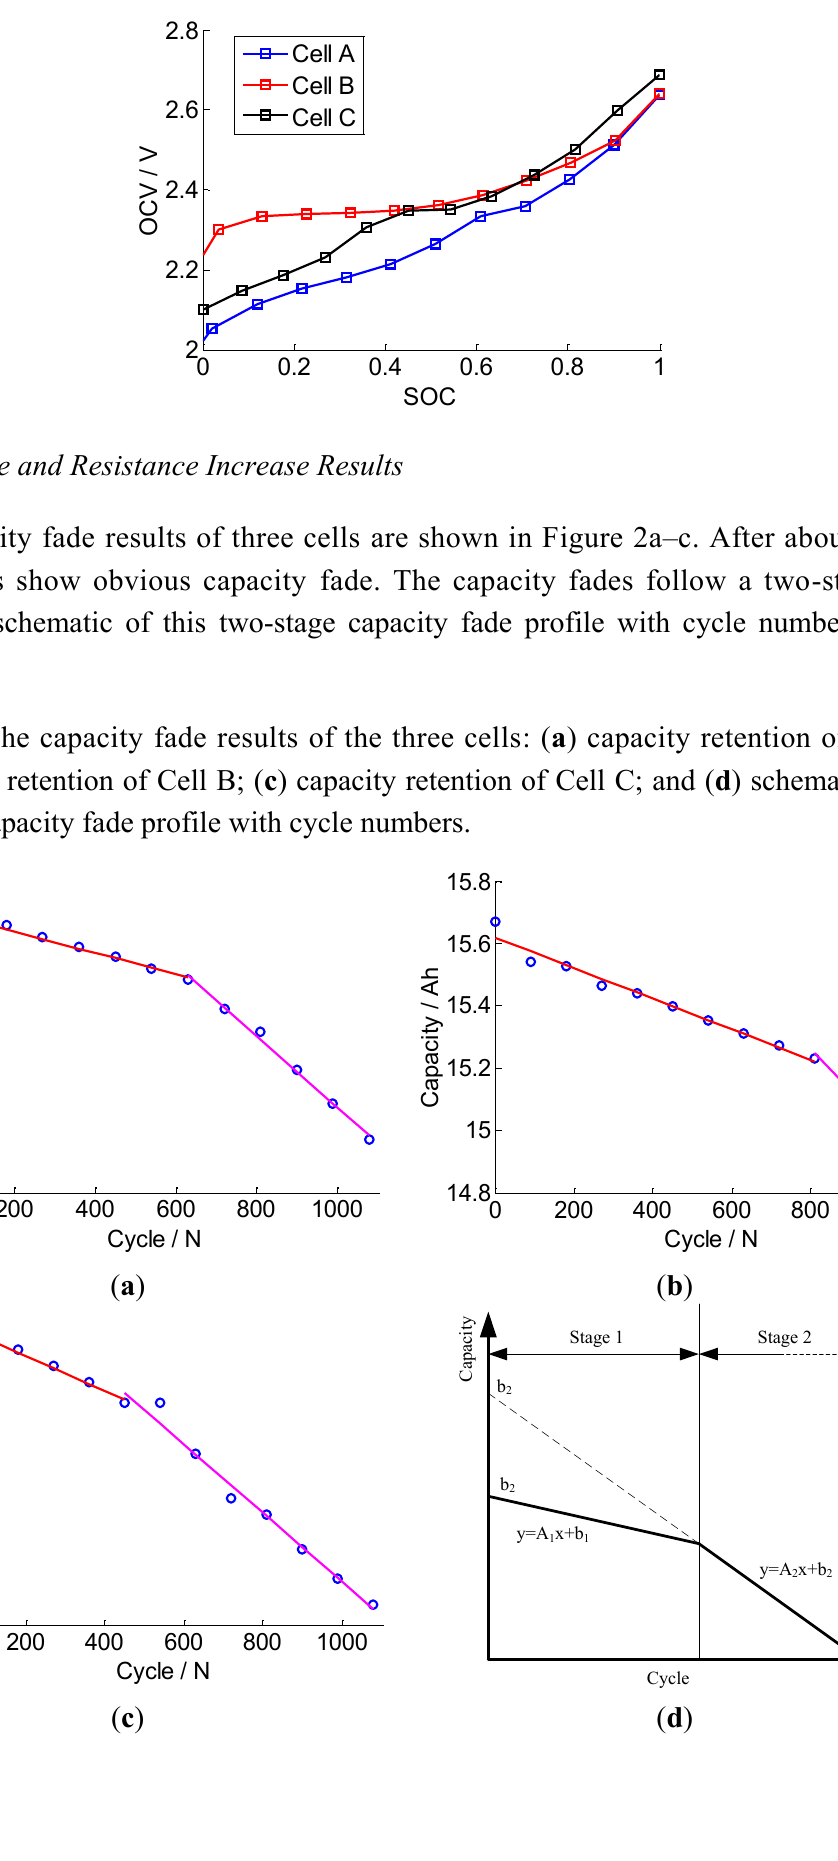
Figure 1. The open circuit voltage (OCV) comparison. SOC: state of charge.